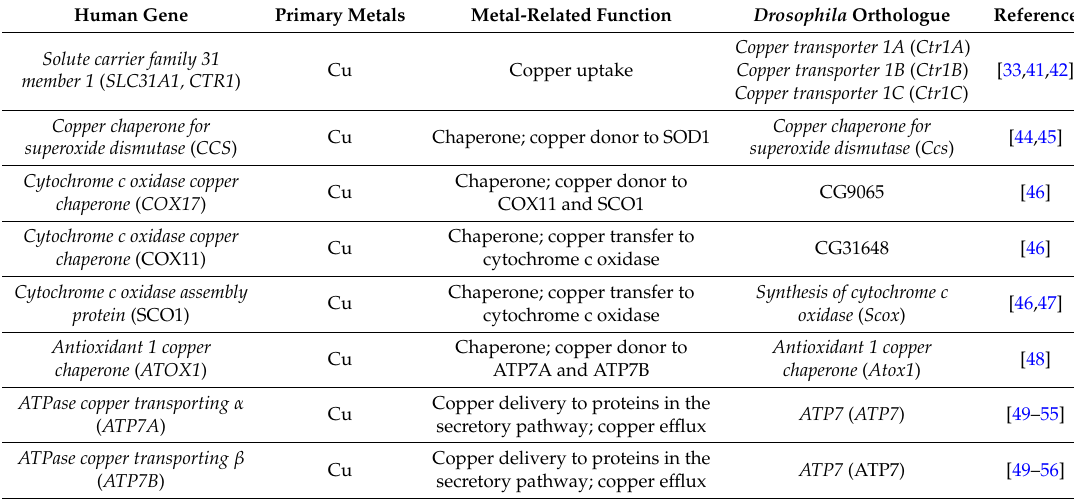
Table 2. Conserved proteins in copper